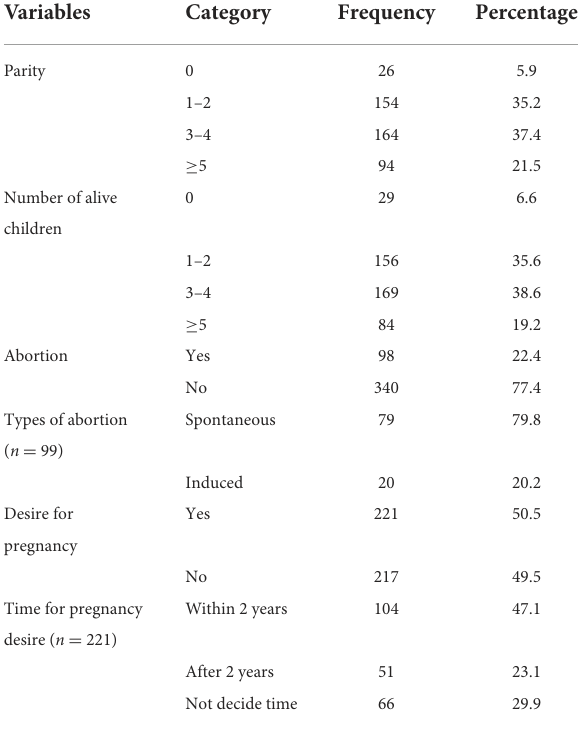
TABLE 2 Pregnancy and related characteristics of Implanon users women visiting public health facilities to discontinue Implanon in Kembata Tambaro zone, South Ethiopia, 2020 ( n = 438).